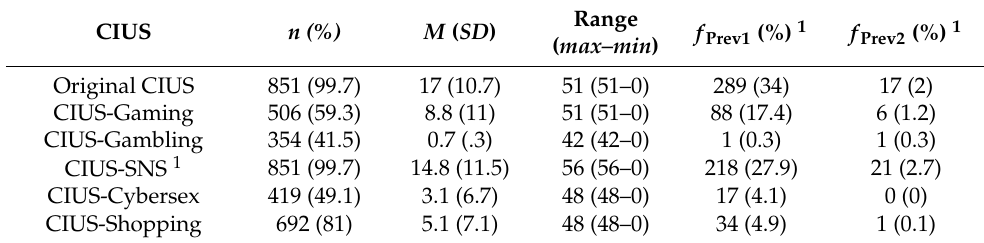
Table 1. Descriptive statistics of the six Compulsive Internet Use Scale (CIUS) versions.